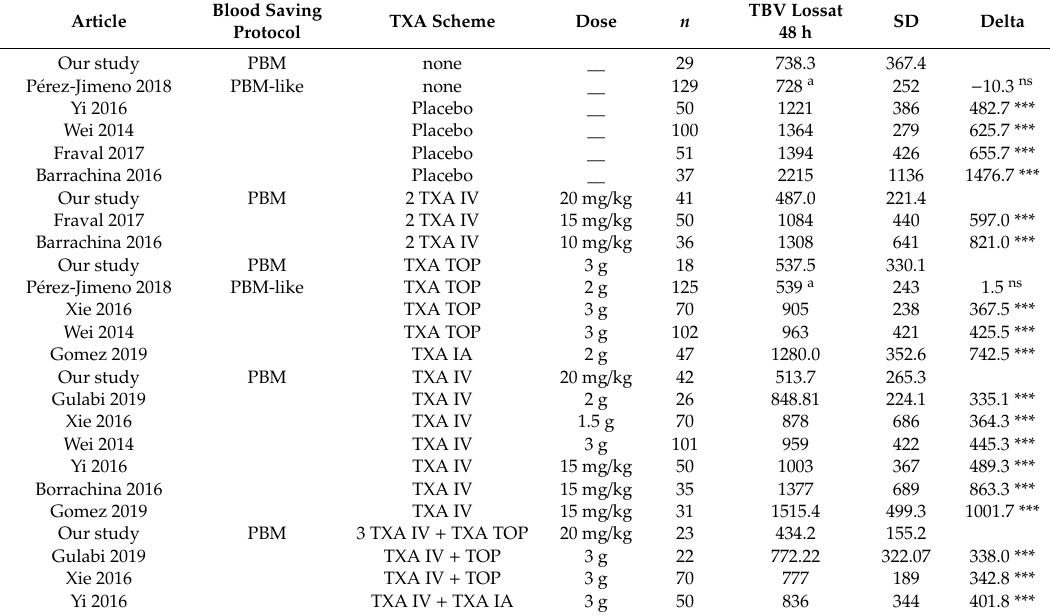
Table 4. Comparison of blood loss of published articles with this study